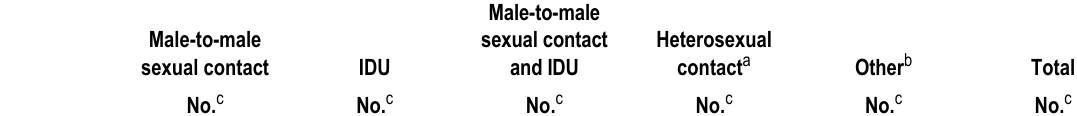
Table 6a. Stage 3 (AIDS), by transmission category, race/ethnicity, and selected characteristics, 2015—United States